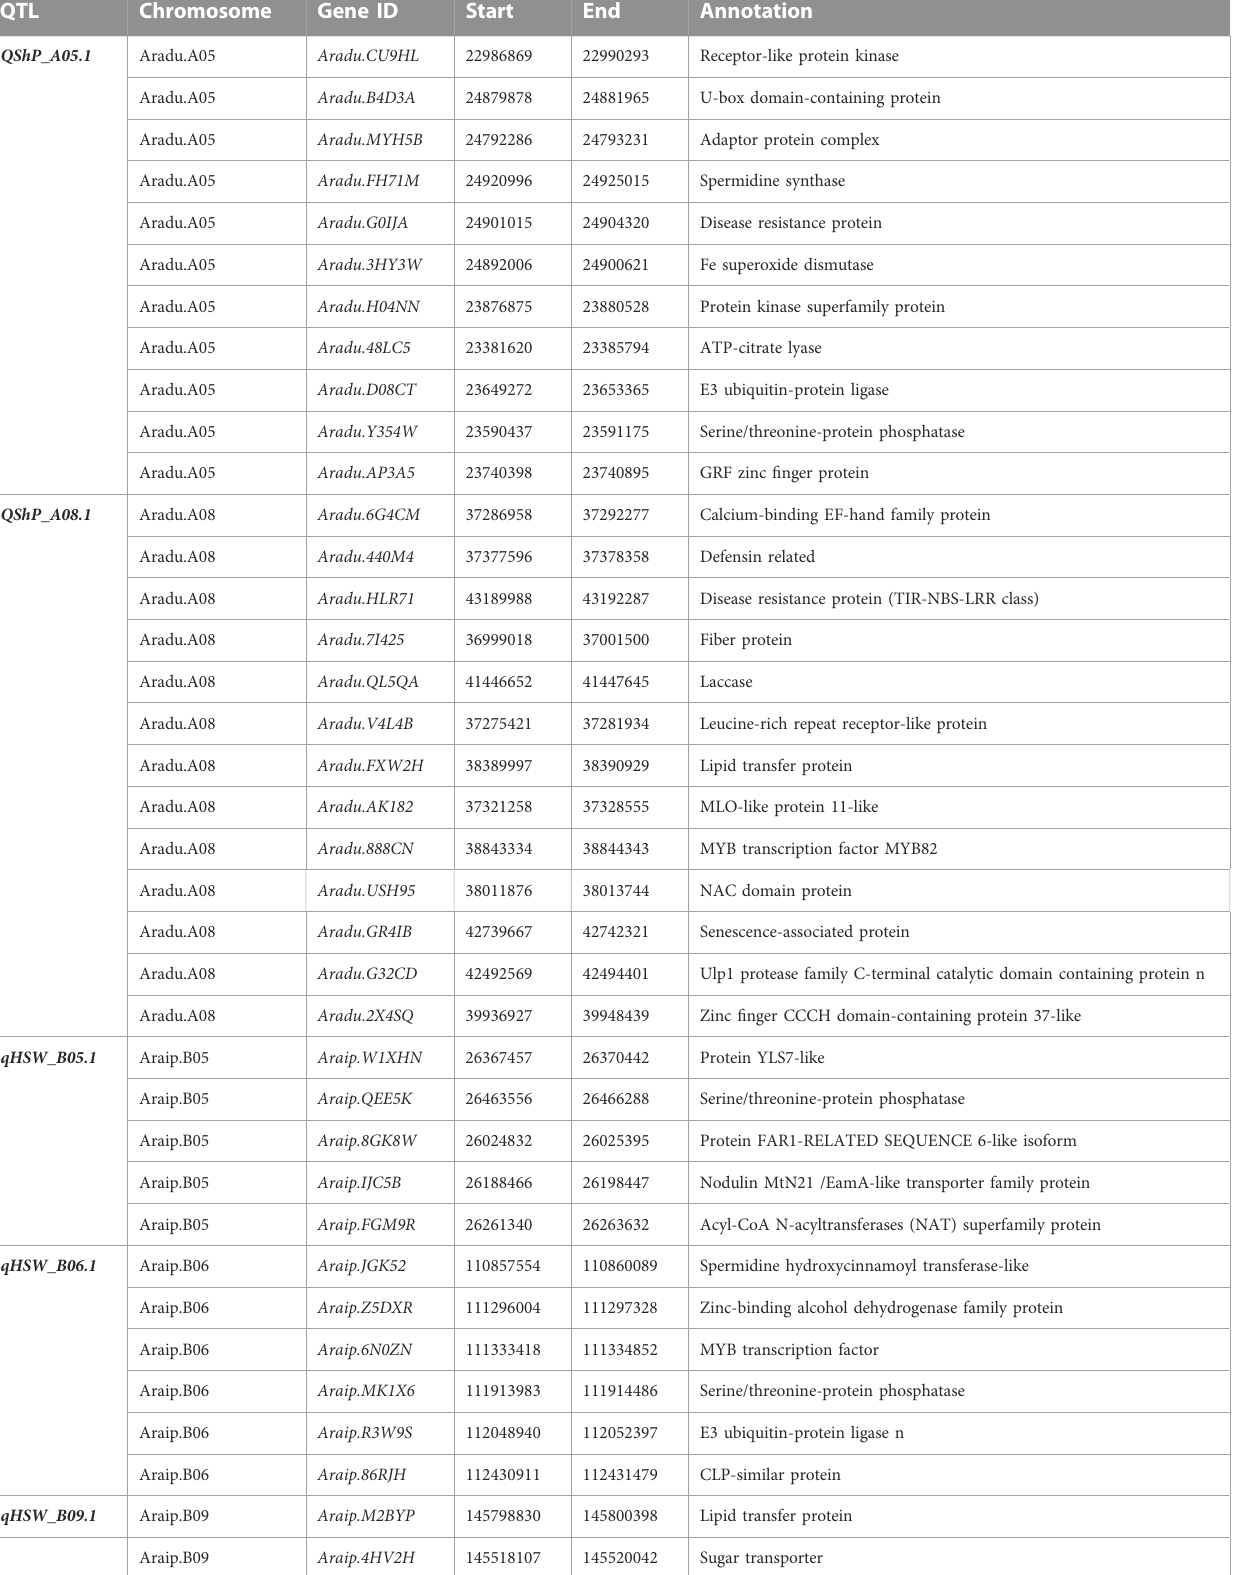
TABLE 3 Potential candidate genes identi fi ed for hundred-seed weight and shelling percentage in major QTL regions. QTL Chromosome